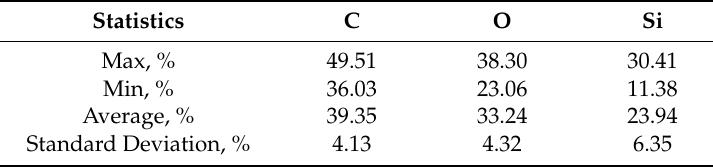
Table 1. Chemical composition of plastinated bamboo-derived using EDS.